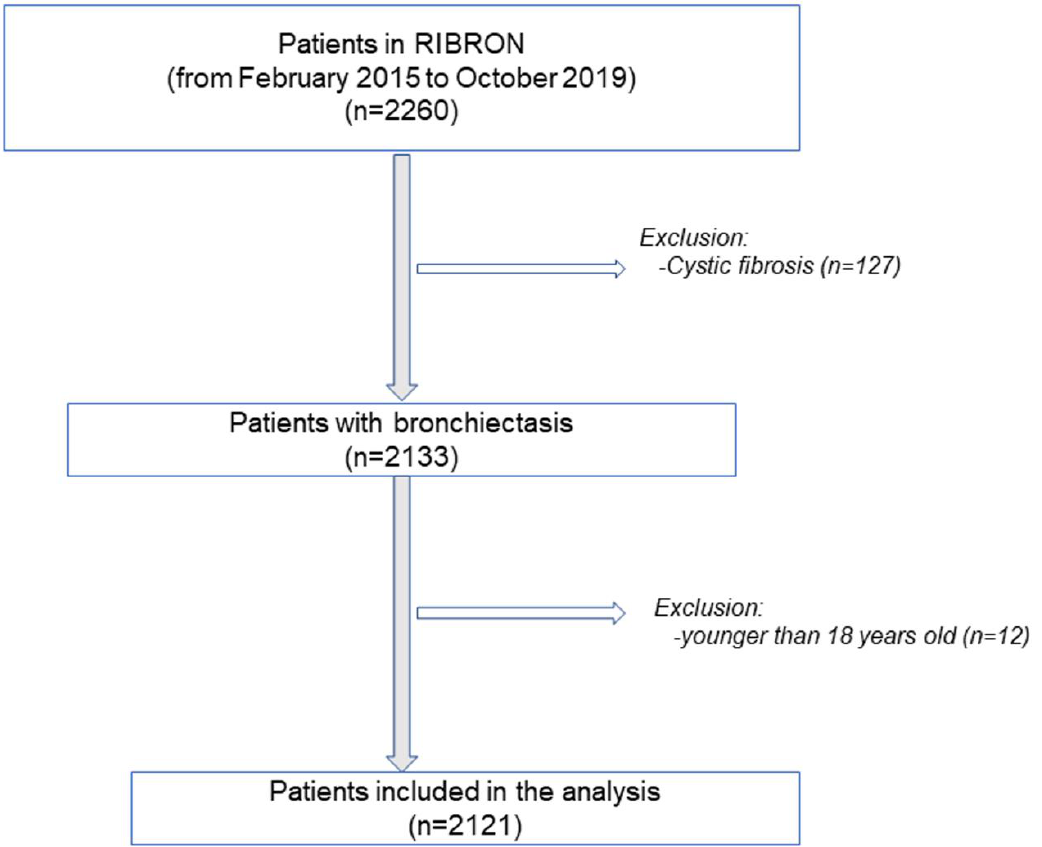
Figure 1. Flow-chart of the recruitment of the study patients.